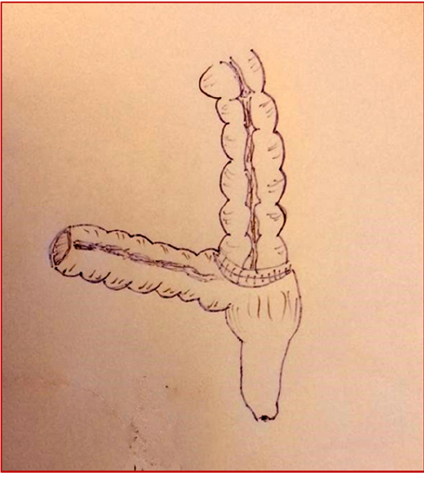
Figure 4. Cologne pouch technique: end-to-side colo-rectal anastomosis.